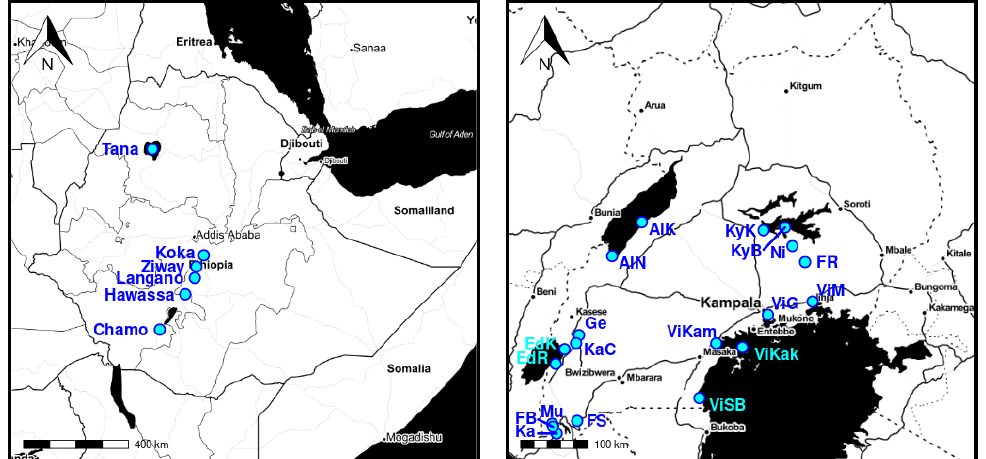
Figure 3. The locations in Ethiopia ( left ) and Uganda ( right ) used for this study. All images were also gathered in these locations. The cran R [36] package rosm [37] relying on the OpenStreetMap was used to generate the